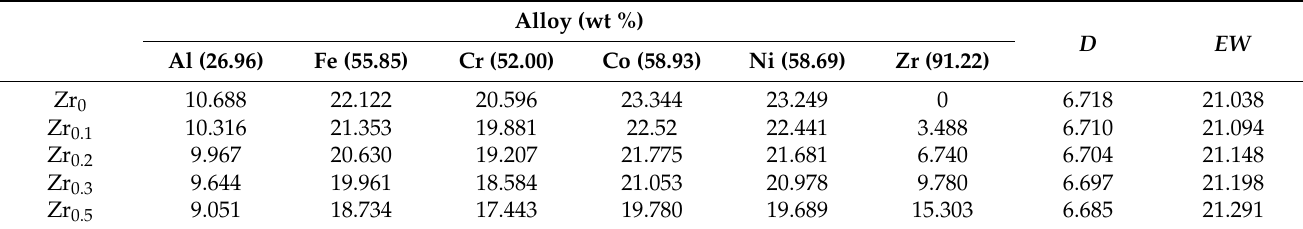
Table 1. Chemical composition, density ( D ), and equivalent weight ( EW ) of as-cast AlCoCrFeNiZr x